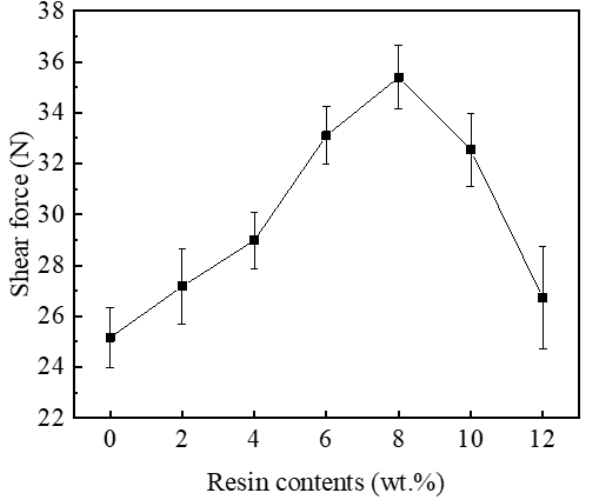
Figure 9. Shear forces of plain SAC305 and SAC305-ER solder joints.